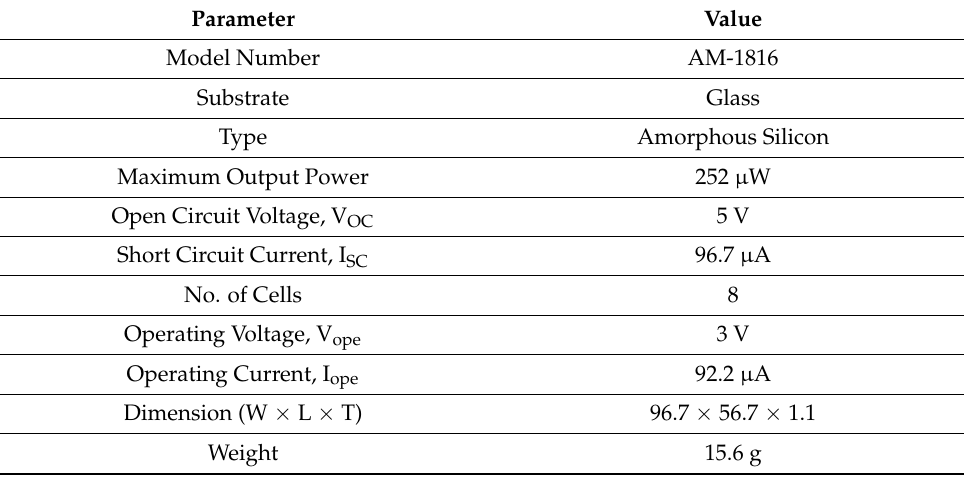
Figure 2. Schematic diagram of the proposed solar PV energy harvesting system for autonomous sensors in smart home applications. Table 1. Electrical specifications of the AM-1816 Solar PV module [38].